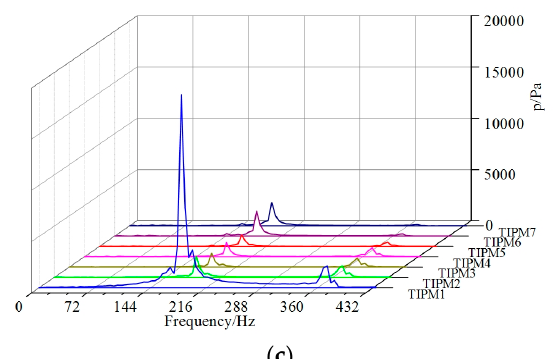
Figure 13. Spectrum analysis of the pressure fluctuations on TIPM1–TIPM7. ( a ) δ = 0.2 mm; ( b ) δ = 0.65 mm; ( c ) δ = 1.0 mm.